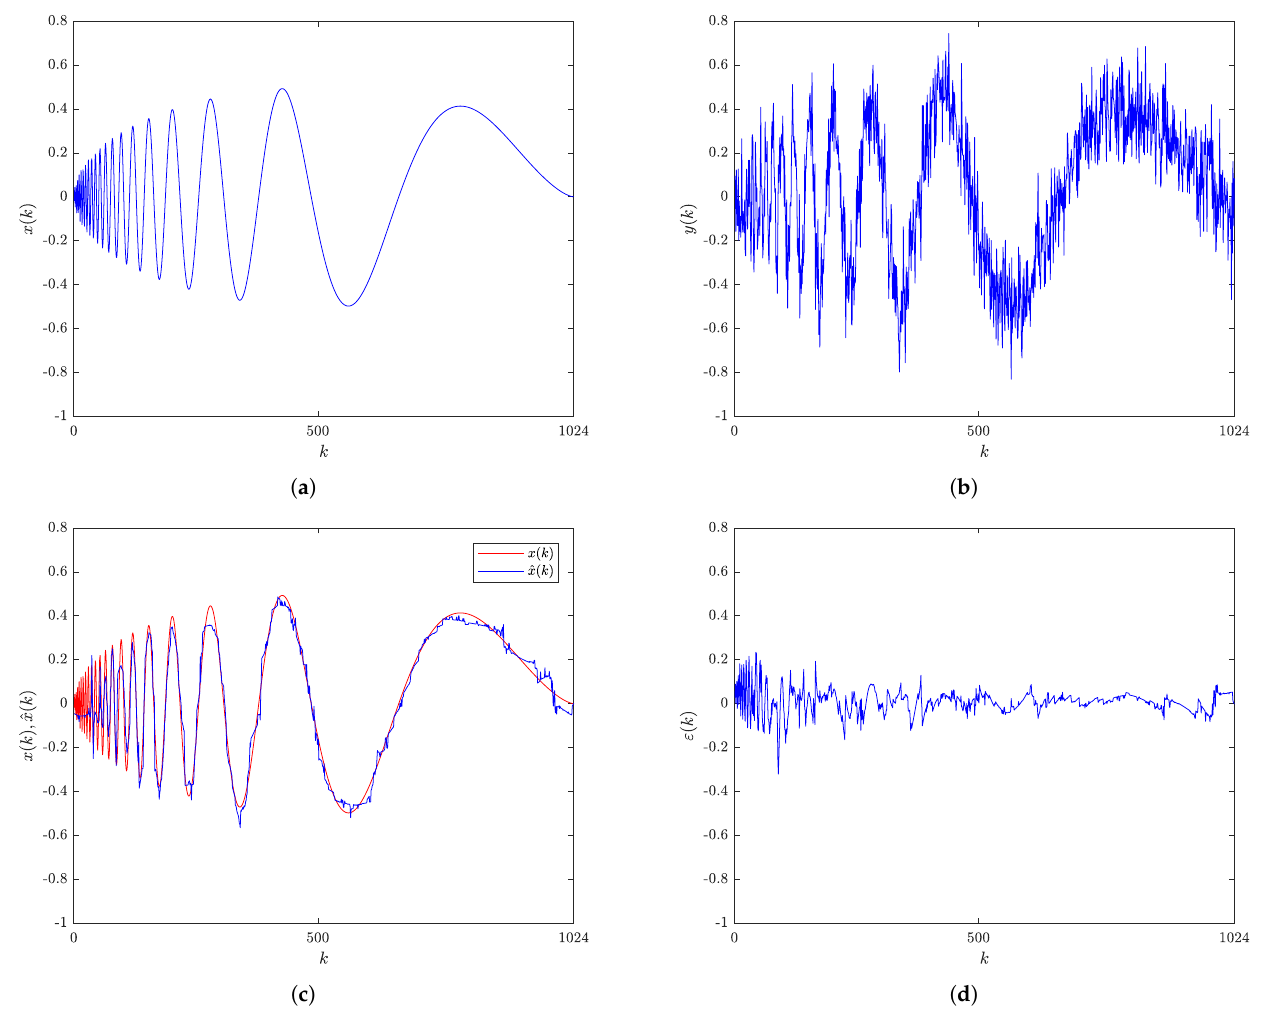
Figure 3. Doppler signal: ( a ) Original signal. ( b ) Noisy signal (SNR = 7 dB). ( c ) Original and RBF-RICI filtered signal ( Γ = 2.29, R c = 0.94). ( d ) Filtering error. Table 16. Doppler signal (SNR = 7 dB)—Filtering results.